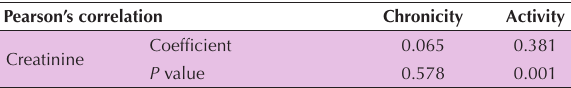
Table 7. Correlation among creatinine, activity and chronicity Pearson’s correlation Chronicity Activity